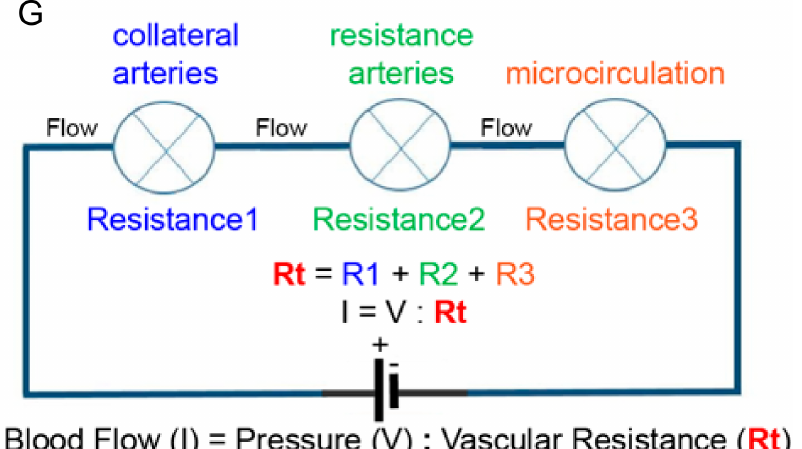
Figure 1. Schematic illustration of an arterial network indicated as electrical resistances coupled in series to a battery. In electrical terms: I (current) = V (voltage) divided by R (resistance), in biological terms Amount of Blood Flow = Pressure difference divided by Peripheral Resistance. The collateral arteries are upstream and coupled in series with the microcirculation. Therefore, changes in the resistance of the microcirculation affect the blood flow through the network. Lowering resistance R3 (microcirculation) will result in lower total resistance (Rt). As a consequence, at a given pressure difference (P), more flow will go through the arterial network. Subsequently, the upstream arterial collaterals (Resistance 1) will become exposed to more flow and shear stress levels, and increased shear stress stimulates outward lumen remodeling of collateral arteries. Diabetes and hypertension interfere with this feedback